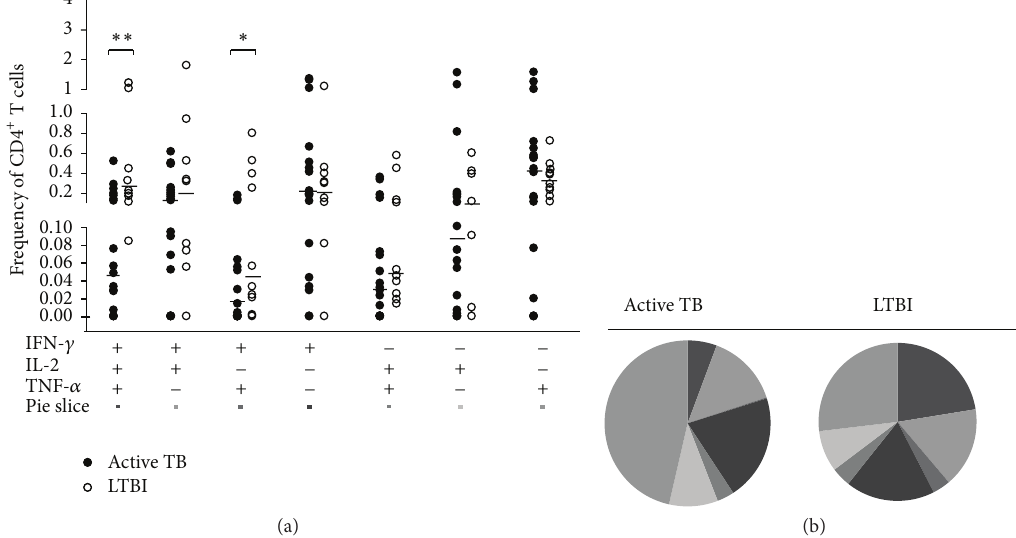
Figure 3: Multifunctional cytokine analysis of M. tuberculosis -specific CD4 + T cells. (a) Frequency of Mtb -specific CD4 + T cells producing all combinations of IFN- 𝛾 , IL-2, and TNF- 𝛼 in active TB patients ( 𝑛 = 18 , black circles) and in LTBI patients ( 𝑛 = 10 , white circles). Horizontal bars represent the median values. Statistical analysis was performed using Mann-Whitney test and significant differences are indicated by asterisks ( ∗∗ 𝑃 < 0.01 , ∗ 𝑃 < 0.05 ). (b) Pie charts represent the relative proportions of cytokine-producing T-cell subsets in each group after Mtb -specific stimulation. A key to colours used in the pie charts is shown at the bottom of the panel